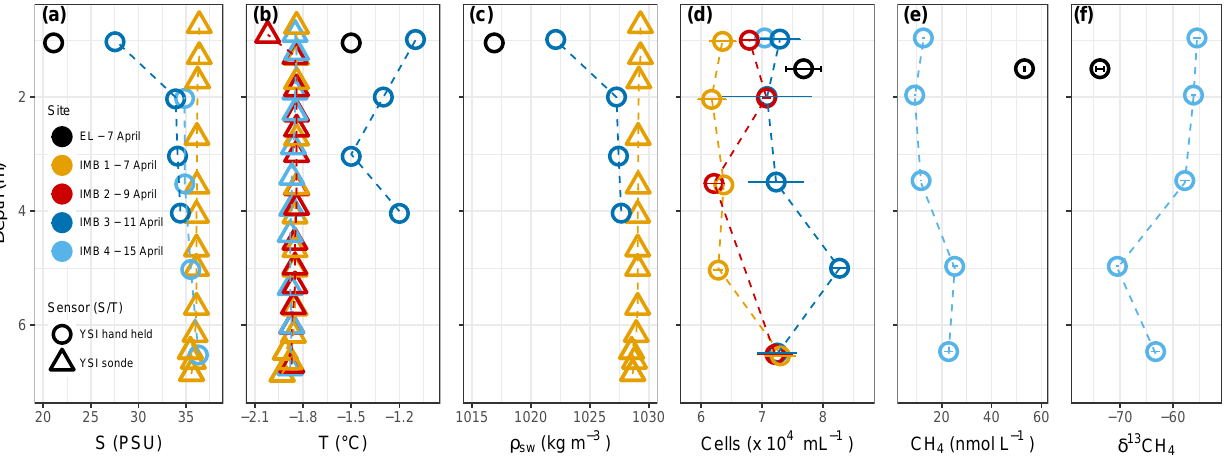
Figure 1. Water column properties during the time series near Utqiagvik. Salinity (a) , temperature (b) , density (c) , cell abundance (d) , methane concentration (e) and stable isotope ratios (f) . Error bars on cell numbers (d) represent the standard deviation on two technical replicates. Salinity and temperature ( a and b ) were determined with a YSI hand held (circle) and YSI sonde (triangle). Salinity for the YSI hand held on 15 April was determined in the laboratory, thus in situ temperature is missing. Salinity for the YSI sonde on 9 and 15 April is missing due to freezing of the sensor. Methane data is only available for EL on 7 April and for IMB 4 on 15 April.